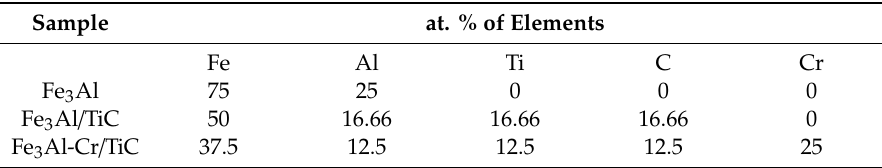
Table 1. Nominal composition of the feedstock powder before milling.